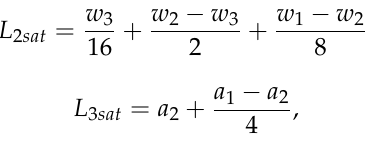
Figure 8. Dimensions of magnetic E-core for modified reluctance calculation.